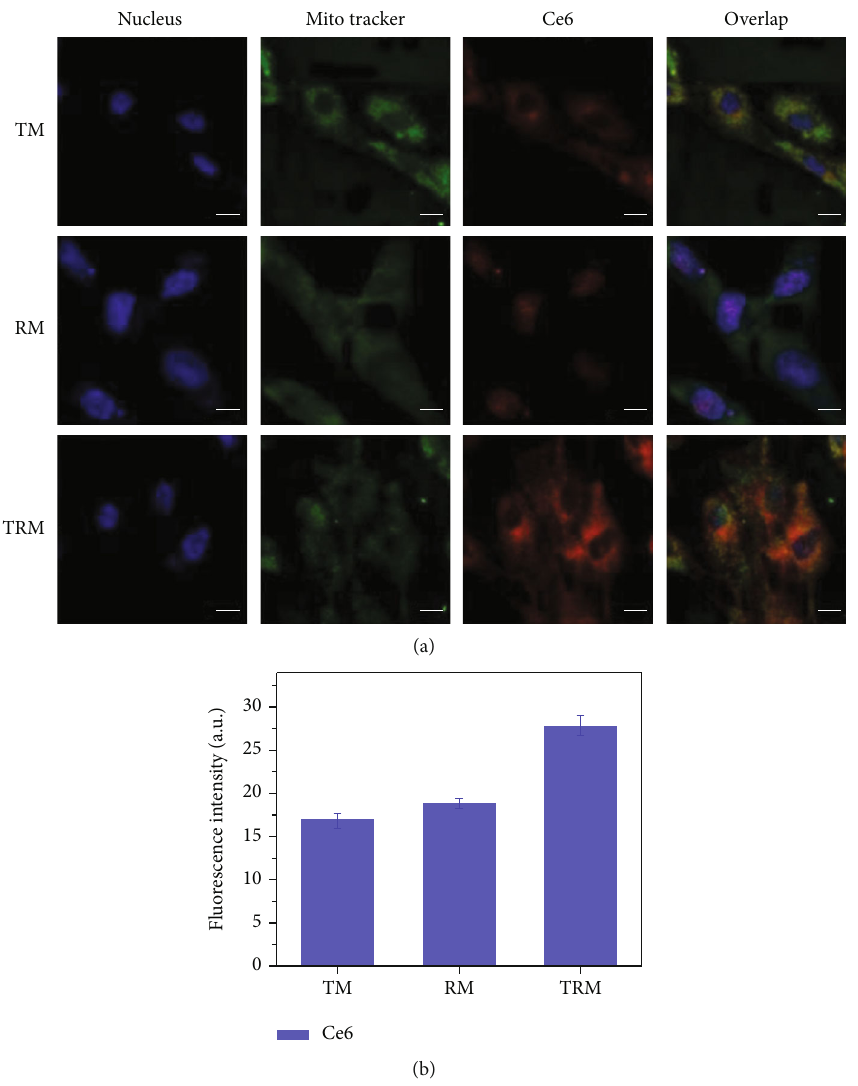
Figure 6: (a) CLSM images of C6 cells and intracellular ROS generation after treating with TM, RM, and TRM for 4h with laser irradiation. Scale bar was 20 μ m. (b) The fl uorescence intensity of Ce6 delivered into tumor cells by di ff erent